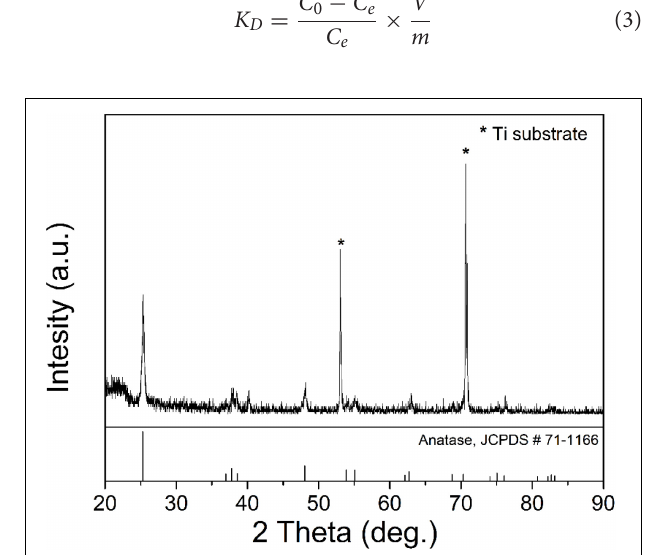
FIGURE 1 | XRD pattern of TiO 2 /Ti. *Peaks of Ti.